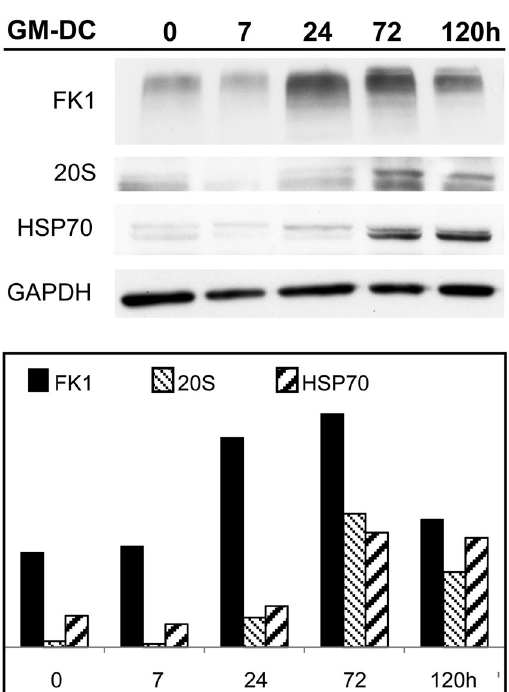
Figure 3. Confocal microscopy of PaCS in IL4-DC. ( A ) IL4-DC incubated for 72 h with GM-CSF plus IL4, processed according to the common sample preparation for confocal microscopy procedure and immunostained with proteasome 20S (green) and p62 (red) antibodies. No positive 20S immunofluorescent structures were visible, while a few small p62-storing fluorescent bodies (red), likely corresponding to autophagosomes, appeared in some cells. ( B ) IL4-DC incubated for 0, 24 or 72 h, fixed, and processed as for TEM and immunostained for 20S proteasome (green). Proteasome-reactive PaCS were visible after 24 and 72 h incubation, but not in control, untreated monocytes. Corresponding phase-contrast images are shown below to help identify the cells. ( C ) Immunofluorescent PaCS were also seen in IL4-DC after 72 h incubation, after immunostaining for polyubiquitinated proteins with FK1 antibody.